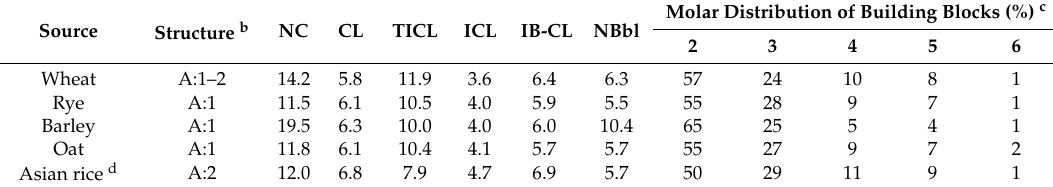
Table 3. Structure of intermediate α -dextrins (“clusters”) isolated from amylopectin with the α -amylase of B. amyloliquefaciens a